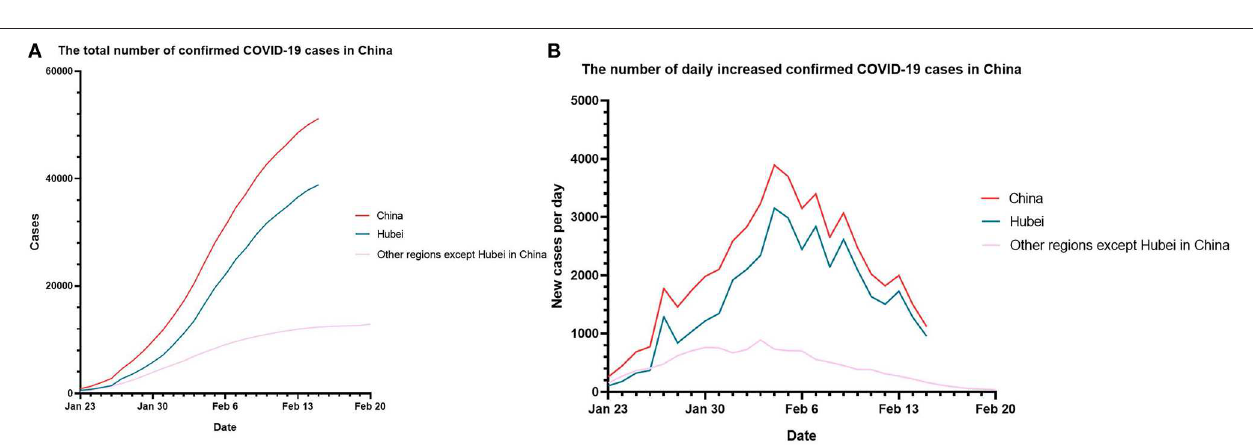
FIGURE 1 | The number of confirmed cases in each province or region of China. Data before January 24, 2020 is presented in purple, data from January 24, 2020 to February 6, 2020 is presented in green, and data from February 7, 2020 to February 20, 2020 is presented in pink. (A) The data of cases in Hubei Province, including clinically diagnosed cases after February 13, 2020. (B) The data of confirmed cases in China except Hubei.